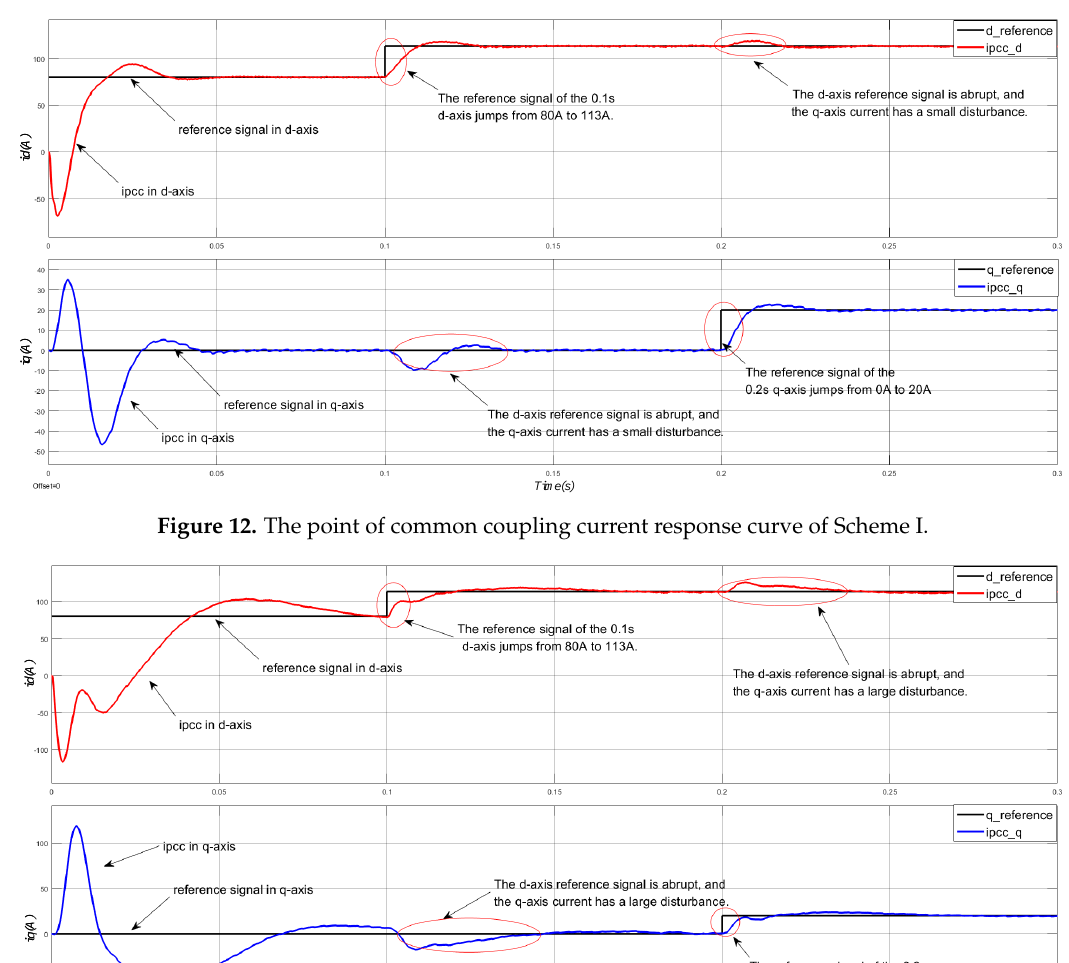
Figure 11. The response curves of TD and Butterworth.